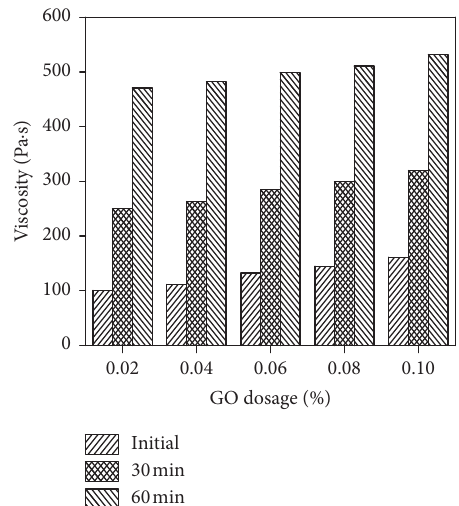
Figure 5: Viscosity of CEAP with different GO dosage.